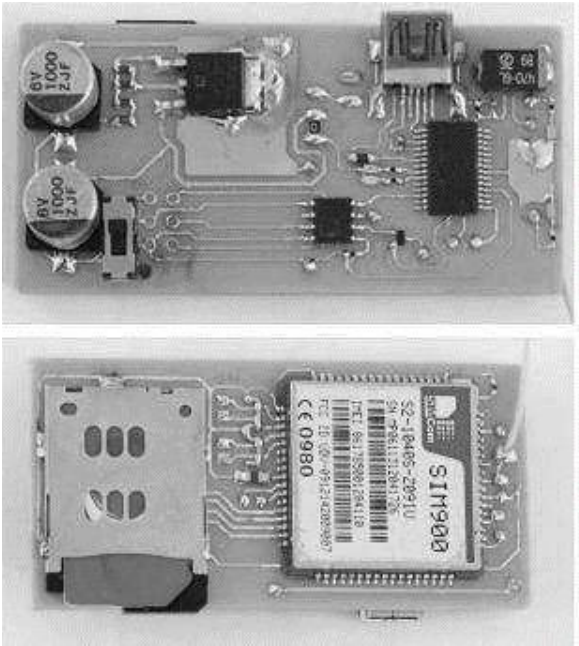
Figure 5. GSM SMS messaging module.